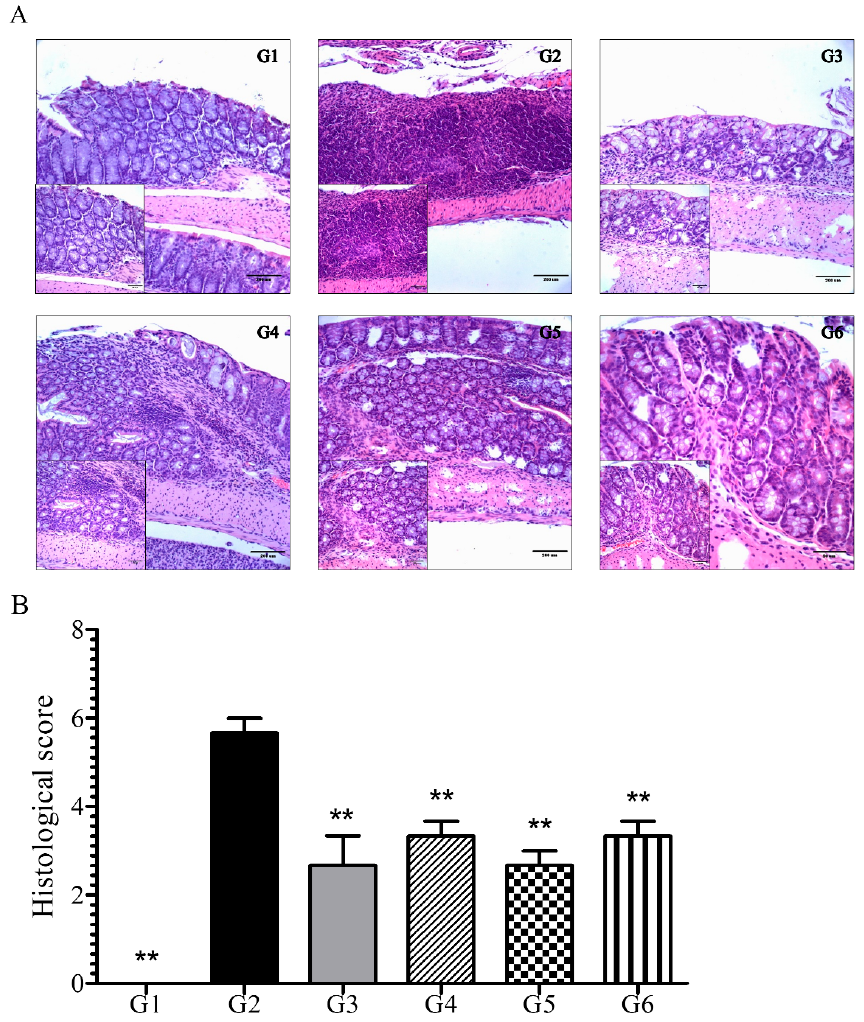
Figure 5. Effect of phytoncide treatment on histological changes on DSS-induced colitis damage. ( A ) Results of the H&E staining, × 100 magnification. ( B ) Effect of phytoncide on histological scores of DSS-induced colitis. G1, normal control; G2, vehicle control (colitis control, DSS 2% in DW); G3, prevention phytoncide oil 10 mL/kg; G4, therapy phytoncide oil 10 mL/kg; G5, prevention pine cone water extract 10 mL/kg; G6, therapy pine cone water extract 10 mL/kg. Representative data are expressed as mean ± SEM of experiments ( n = 10) for each group. ** p < 0.01 compared to vehicle